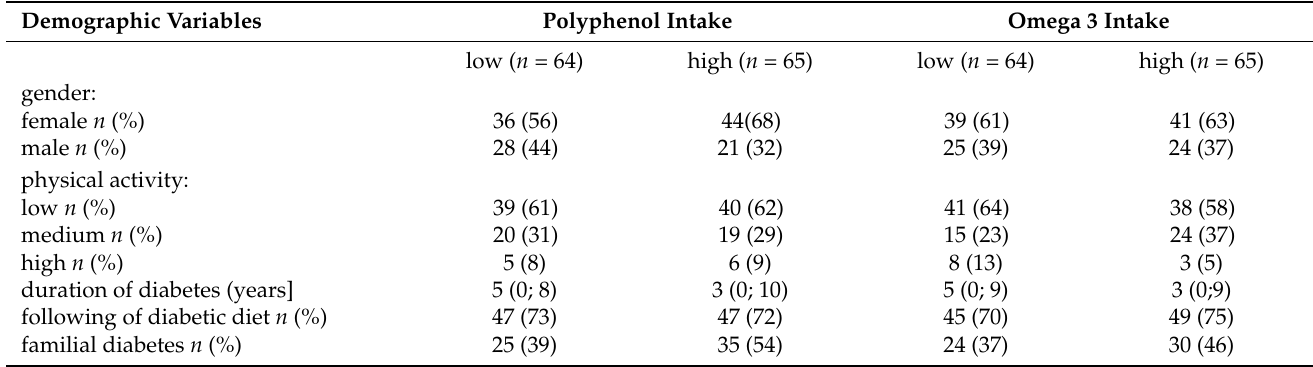
Table 1. Demographic characteristics of T2DM patients depending on the intake of polyphenols or PUFAs omega 3.